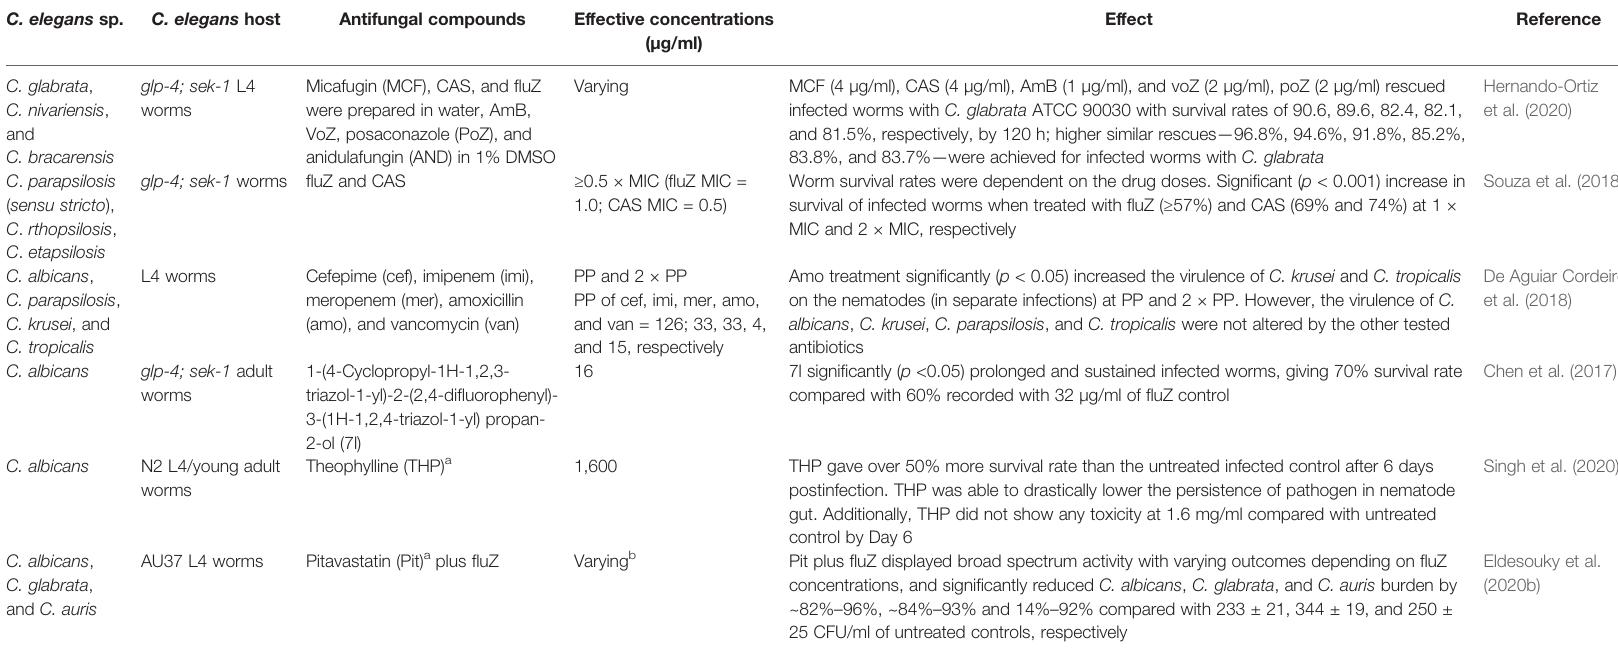
TABLE 6 | In vivo activities of known and repurposed drugs against candidiasis in C. elegans models. C. elegans